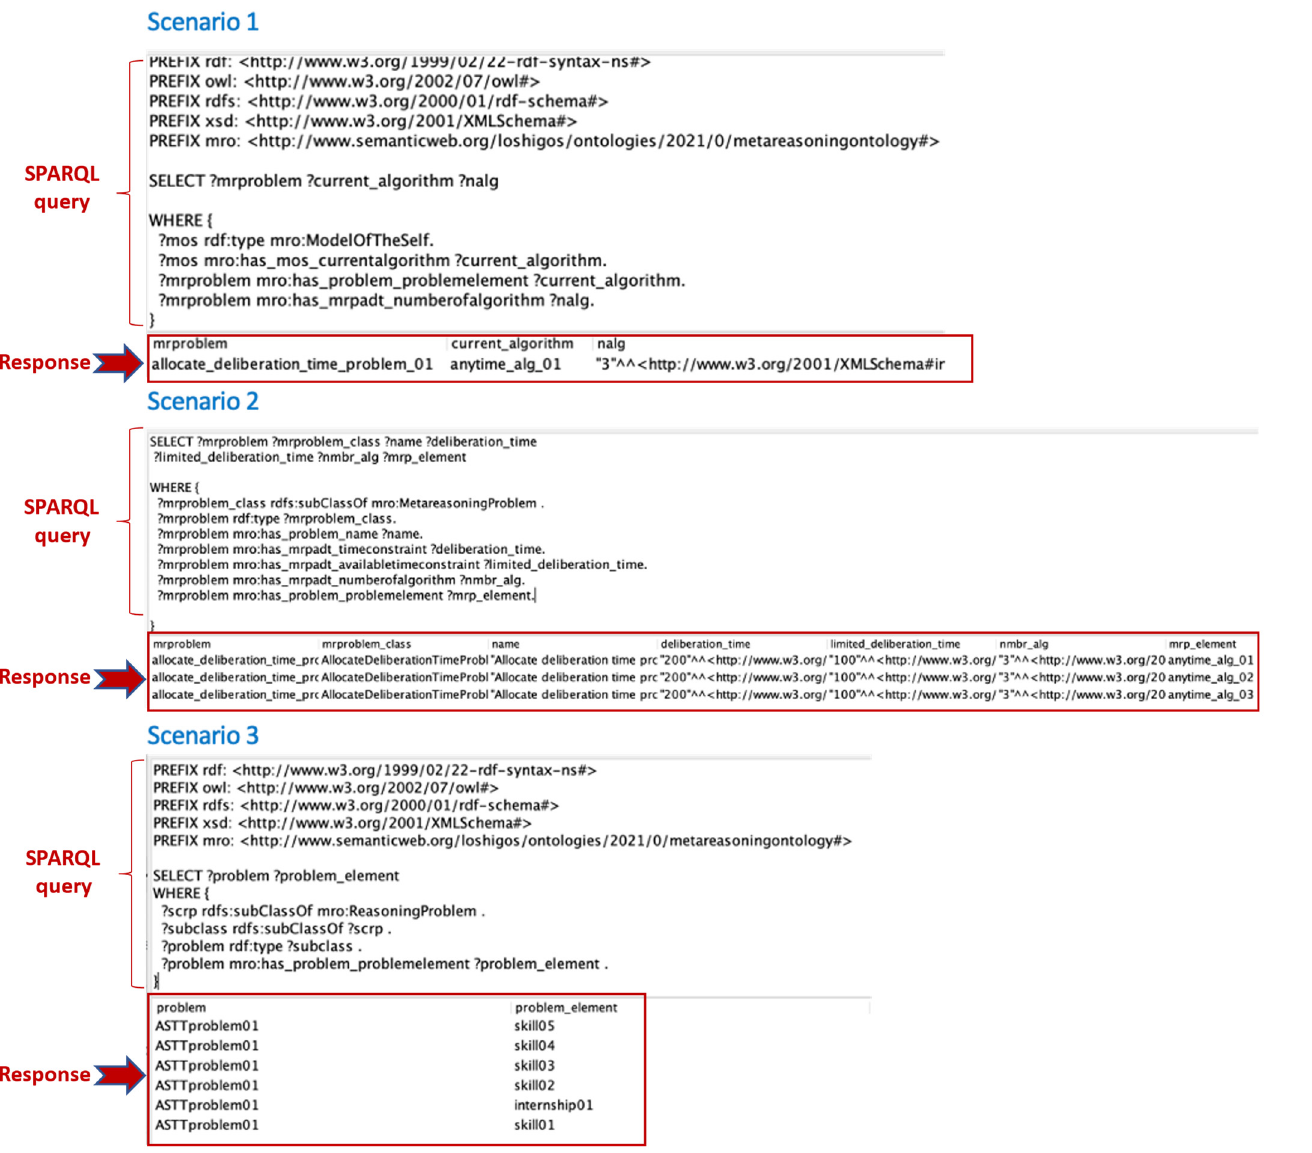
Figure 17. Questions asked to the ontology in SPARQL language.